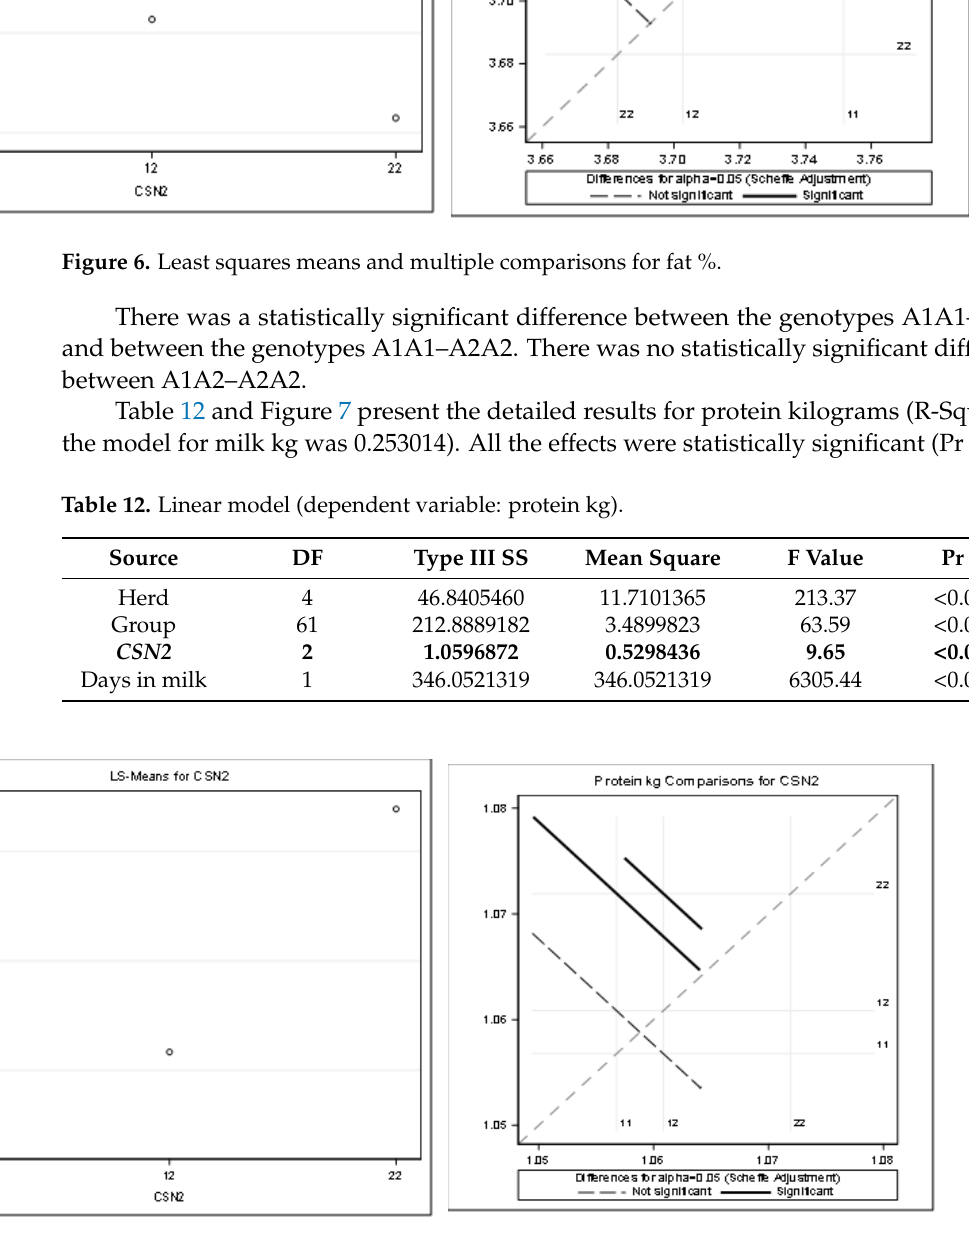
Figure 7. Least squares means and multiple comparisons for protein kg.